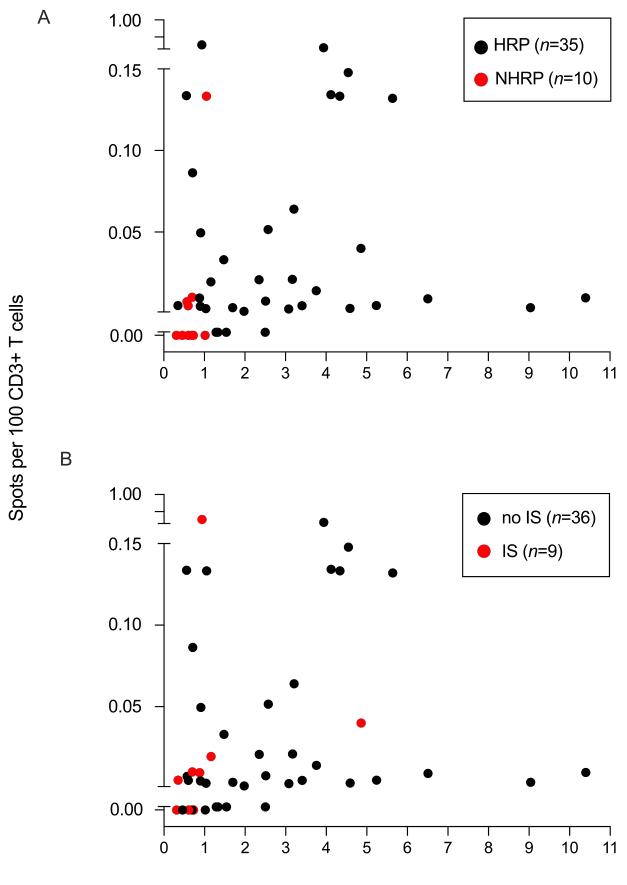
Figure 3. Docking pose of ( α )- 7c ( A ) and ( β )- 7c ( B ) in the catalytic domain 2 of HDAC6 (PDB: 5EDU [29]). Ligands are colored green and are depicted as sticks. The catalytic Zn 2+ -ion is shown as a gray sphere, and water is shown as a red sphere. The protein backbone is shown as light blue cartoon including the wheat-colored protein surface surrounding the ligand. The binding interactions of the hydroxamic acids are depicted as yellow, dashed lines. 2.4. Antiplasmodial Properties and Parasite Selectivity In order to investigate the antiplasmodial properties of the synthesized DHA–HDACi hybrids, all compounds were screened for their activity against the drug-sensitive 3D7 line of P. falciparum and the multidrug-resistant P. falciparum Dd2 line. DHA and vorinostat were included as positive controls. Selected compounds that were tested in the ring stage survival assay with the artemisinin-resistant Dd2 R539T (see Section 2.5) were also